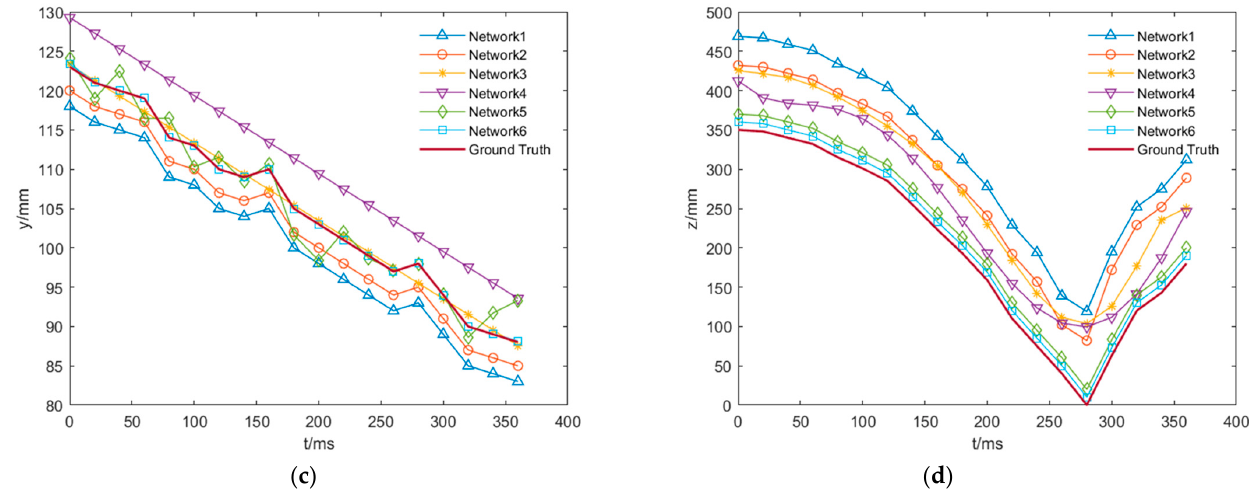
Figure 16. Comparison results of different networks: ( a ) 3D trajectory diagram of the sphere move ‐ ment, ( b ) trajectory of the sphere’s motion in x ‐ coordinates, ( c ) trajectory of the sphere in y ‐ coordi ‐ nate motion, ( d ) trajectory diagram of the z ‐ coordinates of the sphere’s motion.